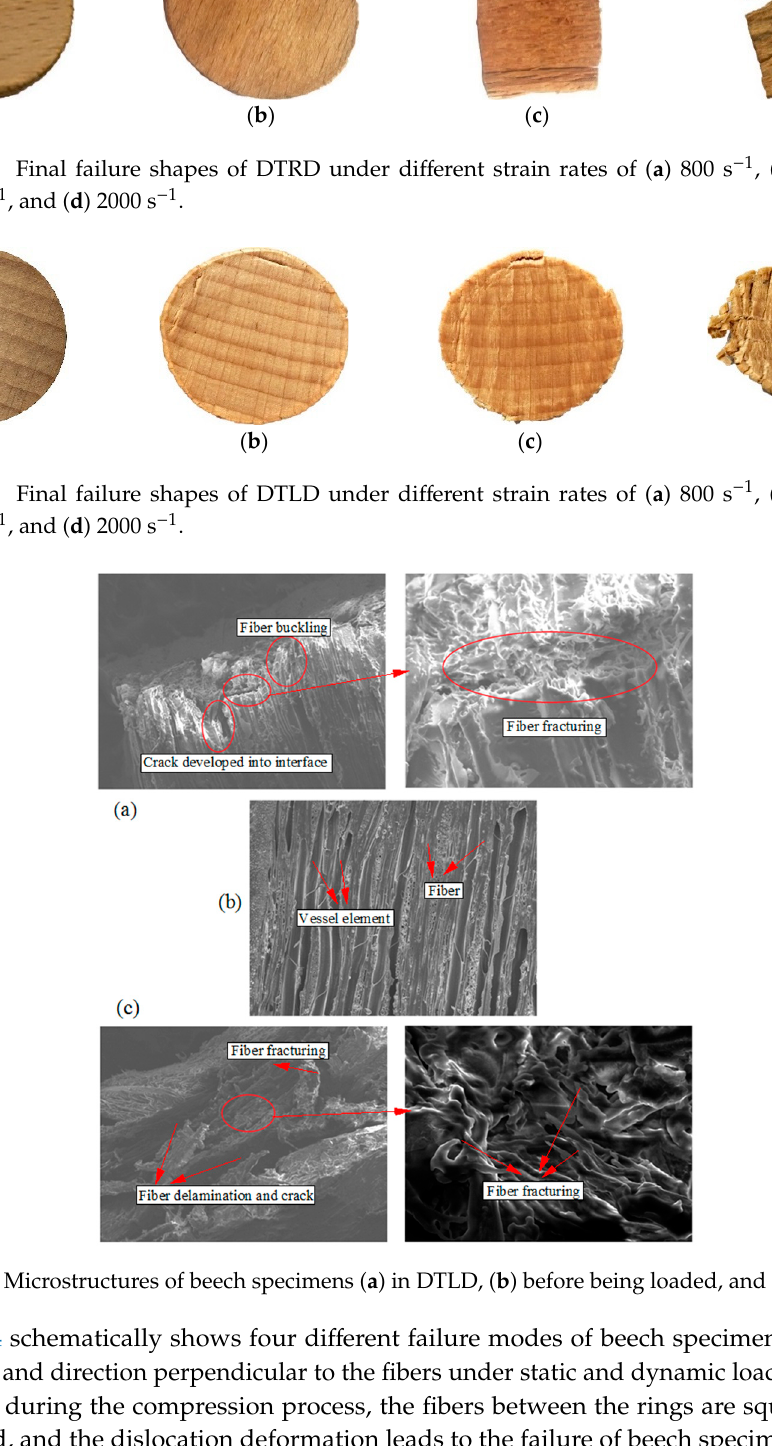
( b ) Figure 10. Absorbed energy per unit volume under different strain rates: ( a ) DTLD results and ( b ) DTRD results. 3.4. Failure Mechanism The beech specimens under high strain rate loading will produce large deformation and even be crushed. The failure mechanisms of beech specimens along the fiber direction and the direction perpendicular to fibers can be investigated at macro and micro scales. Figure 11 and Figure 12 present the final macroscopic failure modes of beech specimens from DTLD and DTRD under different strain rates of 800, 1200, 1800, and 2000 s − 1 , respectively. Figure 13 shows the microscopic failure modes of